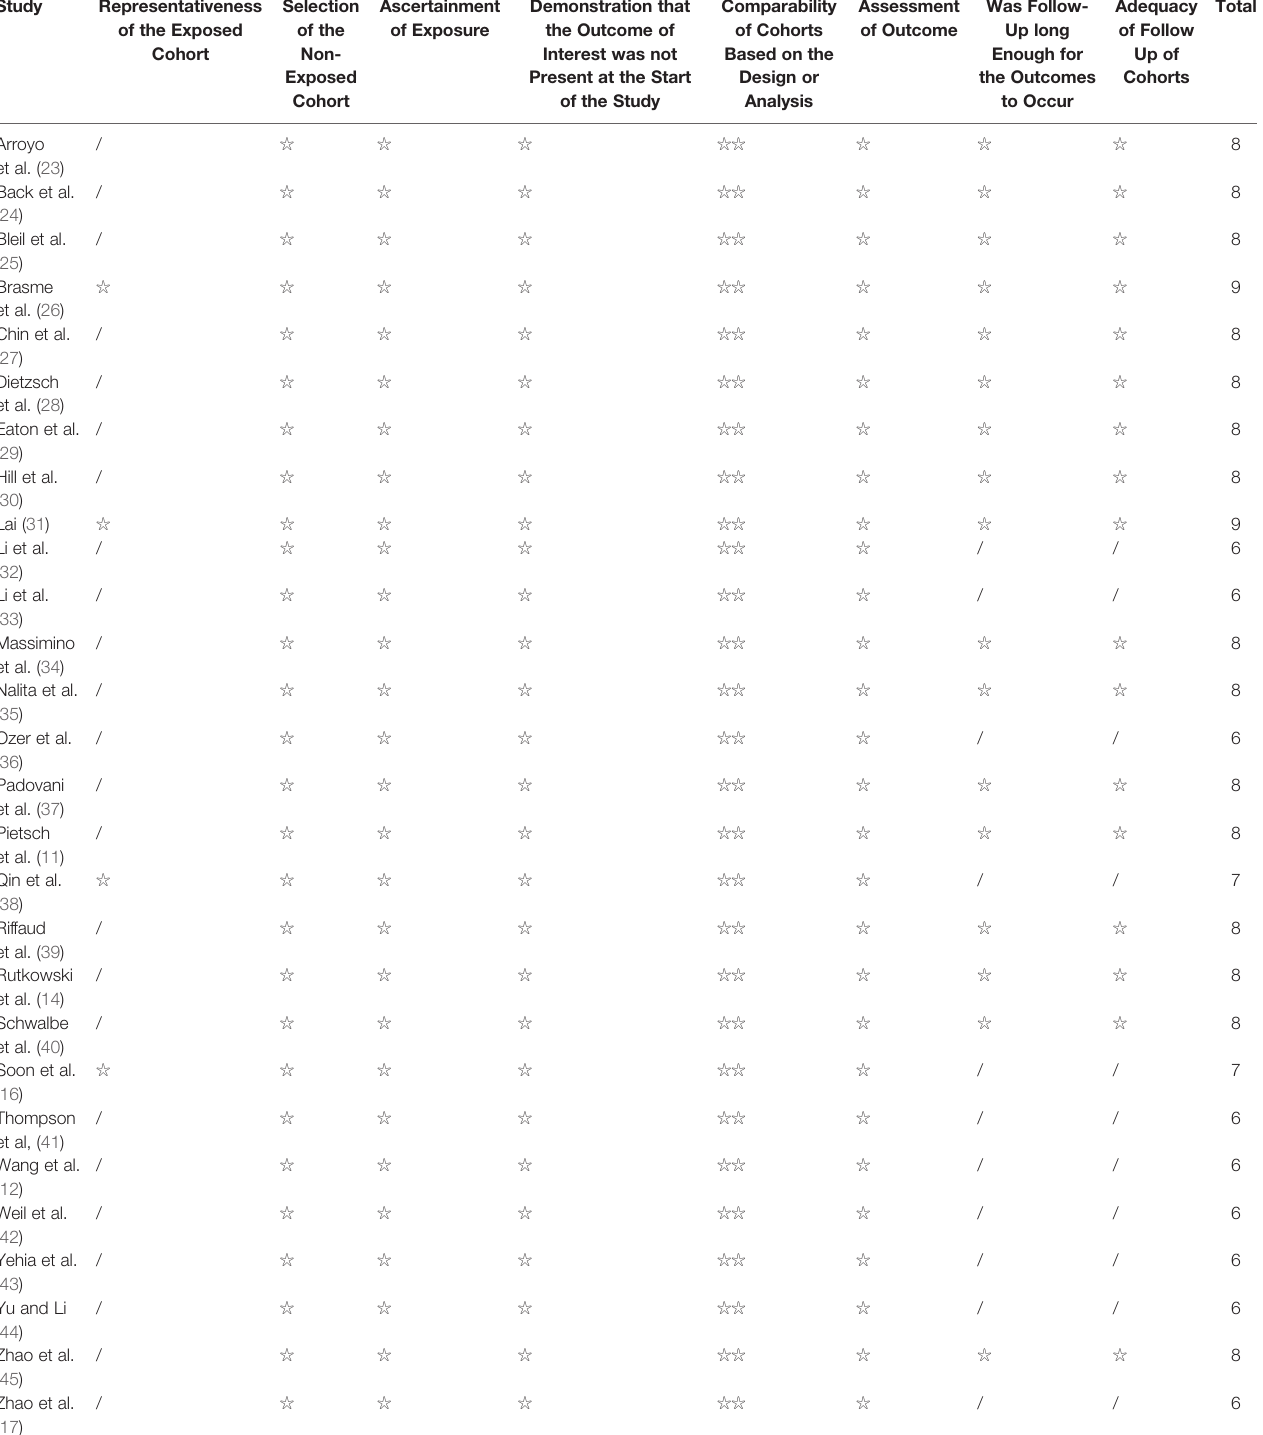
TABLE 1 | Quality assessment of the included